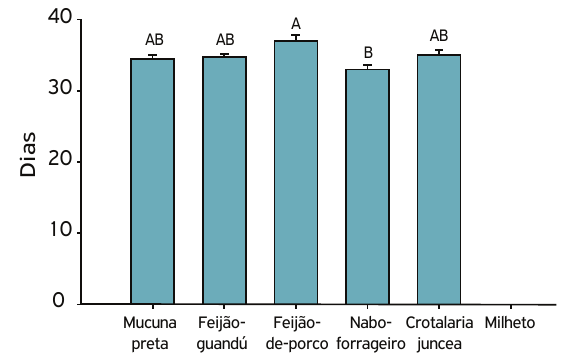
Figura 2. Médias ( ± EPM) da duração total do ciclo de vida (dias) de Spodoptera eridania em diferentes